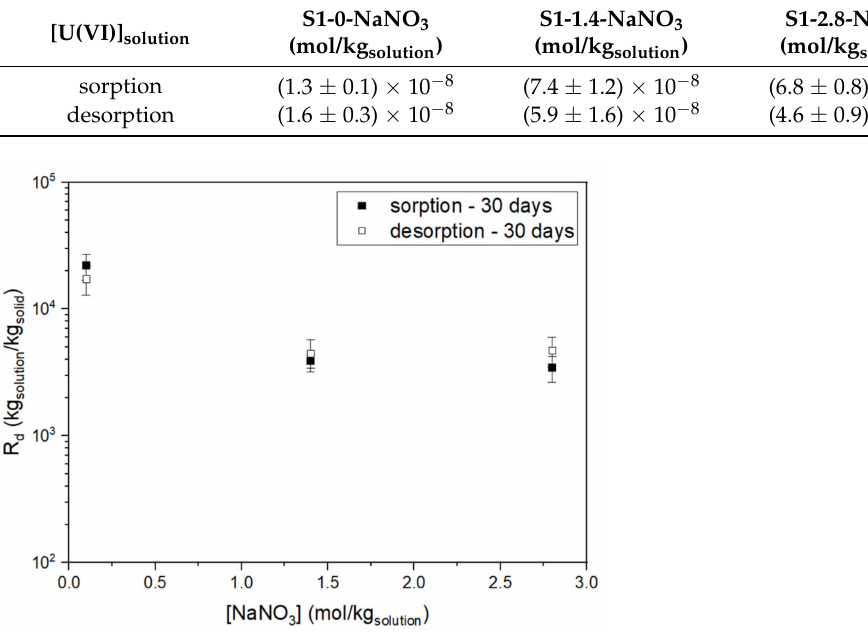
Figure 6. U(VI) sorption and desorption after 30 days of contact time as a function of NaNO 3